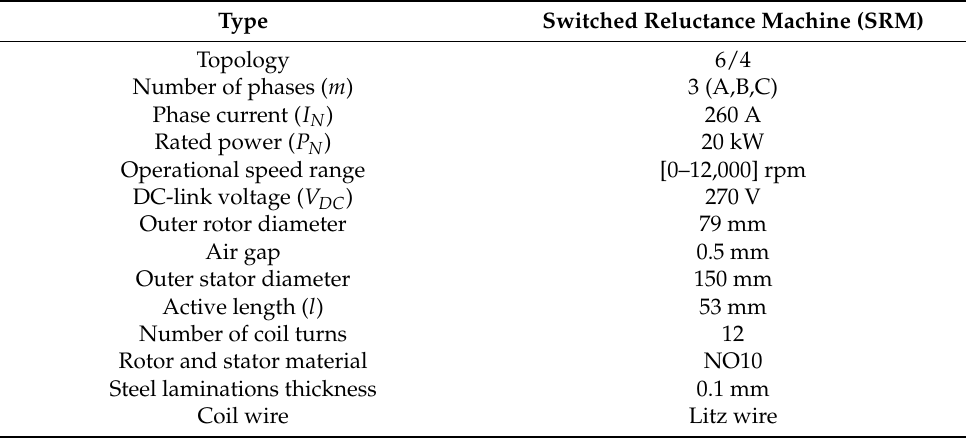
Table 1. SRM design